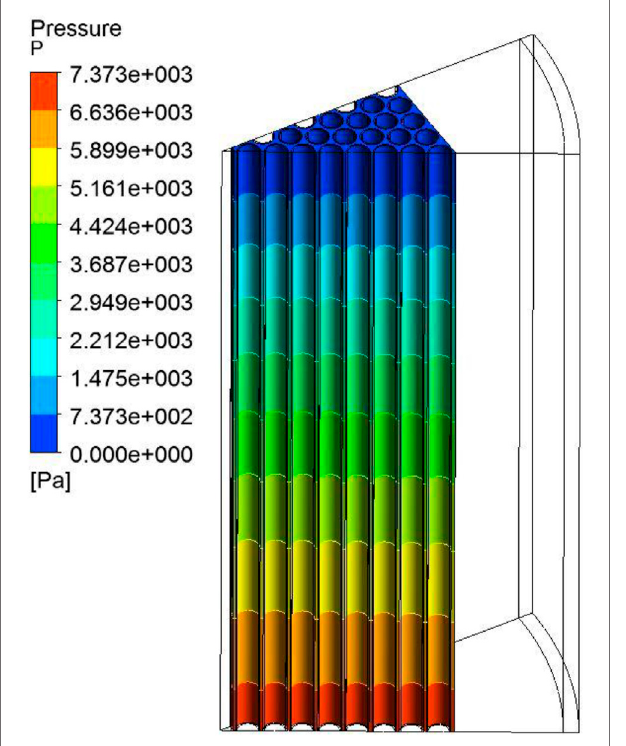
FIGURE 14 | Temperature contour of